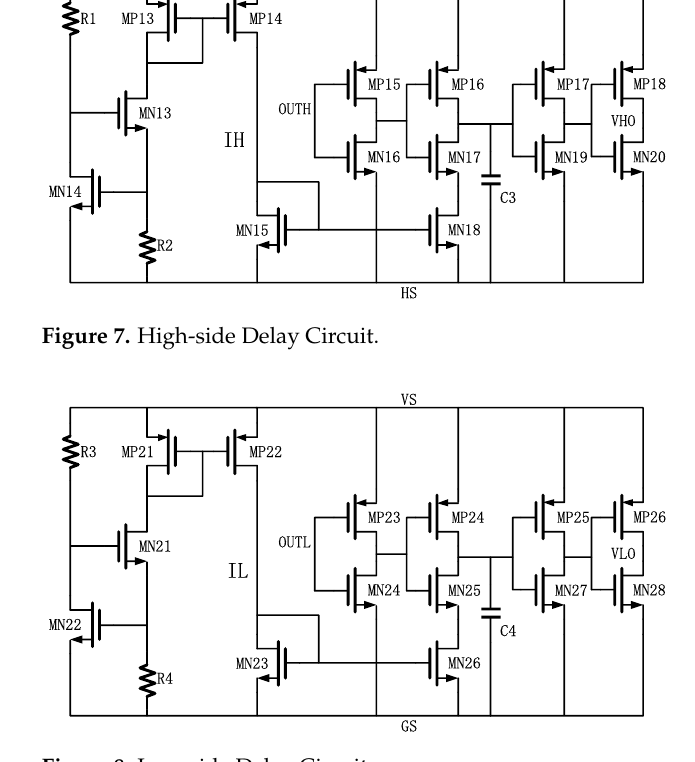
Figure 8. Low-side Delay Circuit.